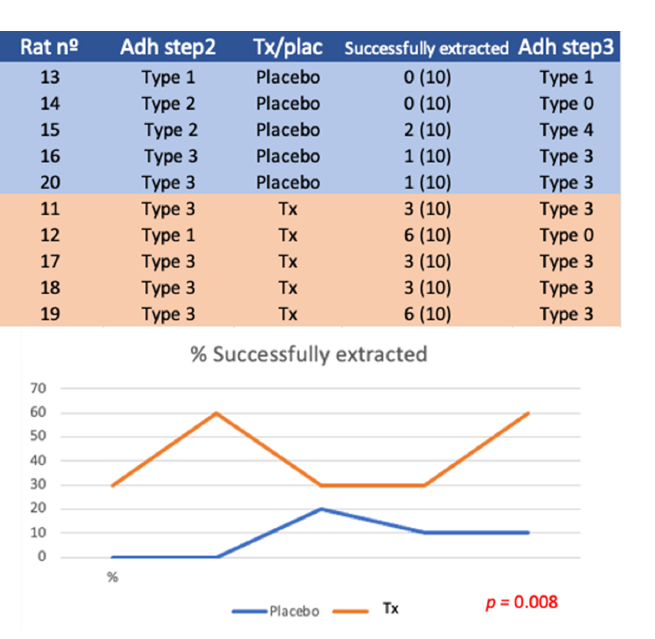
Figure 5. Table experiment A. Successful extraction by type 1 or type 2 maneuver. Graph of experi- ment A. Differences in the number of meshes obtained with treatment vs. placebo are represented in % ( p = 0.013).